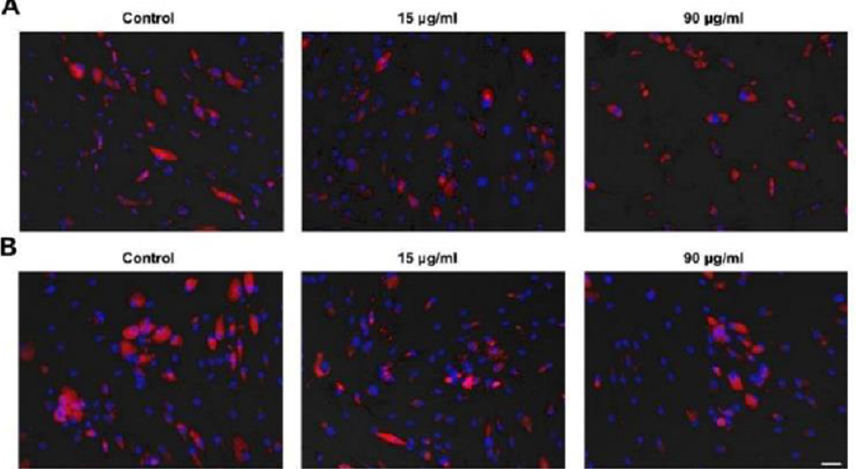
Figure 8. Example pictures of reduced differentiation potential of ADSCs at 5 × magnification. ADSCs treated with clindamycin ( A ) and cefazolin ( B ). Differentiated adipocytes appear with a co-staining of red lipid droplets and blue cell nuclei. ADSCs appear with only blue cell nuclei without red lipid droplets. In both groups, adipogenic differentiation capability was reduced through antibiotic treatment. 2.9. Antibiotic Susceptibility Test A dose of 2 μ g clindamycin resulted in an inhibition zone with a diameter of 28 mm which can be considered susceptible according to the criteria of Clinical and Laboratory